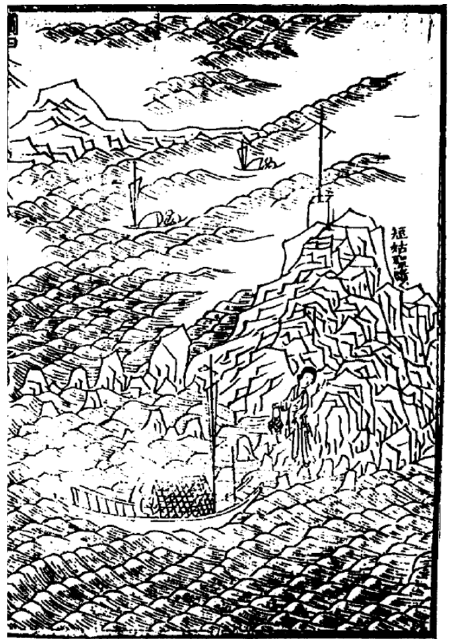
Figure 5. “Sacred Relic of Duangu” in the “Twelve Views of Mount Putuo” (Qiu 1996, p. 史 239–